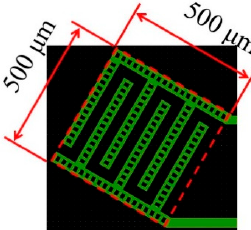
Figure 3. Design drawing of interdigitated array electrodes.